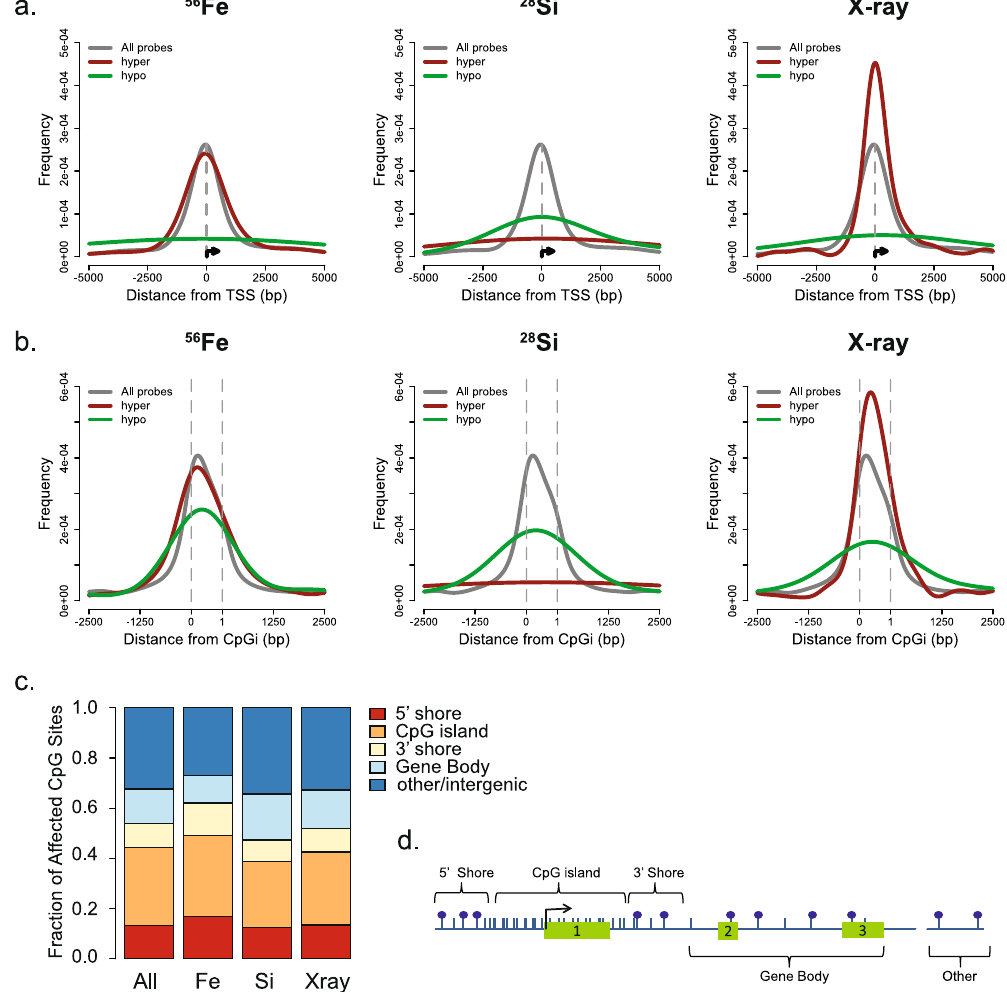
Figure 4. Genomic location of CpG sites significantly associated with radiation dose. ( a ) Average distance of all CpGs on the array (gray), or the subset that underwent hyper (red) or hypo (green) methylation in response to increasing 56 Fe, 28 Si or X ray dose relative to the transcription start site (TSS) of the nearest gene oriented to the direction of transcription. ( b ) Average distance of all CpGs on the array (gray), or the subset that underwent hyper (red) or hypo (green) methylation in response to increasing 56 Fe, 28 Si or X ray dose relative to the nearest CpG island. The distribution within the CpG island is scaled to size (dotted gray lines), and includes a fixed distance of + / − 2.5 kb in either direction from the CpG island edge. ( c ) Fraction of 56 Fe, 28 Si or X ray affected CpG sites that lie within the indicated gene compartment relative to that of All CpG sites interrogated on the array. CpG sites were annotated to the nearest CpG island associated RefSeq gene. CpG islands defined by UCSC criteria, 5 ′ and 3 ′ shores are 2,000 bp from the 5 ′ and 3 ′ CpG island edge. Gene bodies were considered the region from the 3 ′ edge of the CpG island + 2 kb, to the transcription end site (TES). CpG sites not overlapping one of these features were considered to be intergenic/other. ( d ) A schematic of the genomic compartments described in C . Shown is a hypothetical gene (exons-green boxes) for which the TSS (black arrow) is embedded in a CpG island promoter. Blue ticks represent CpG sites, blue balls as methylated CpG sites. The TES would be the end of exon